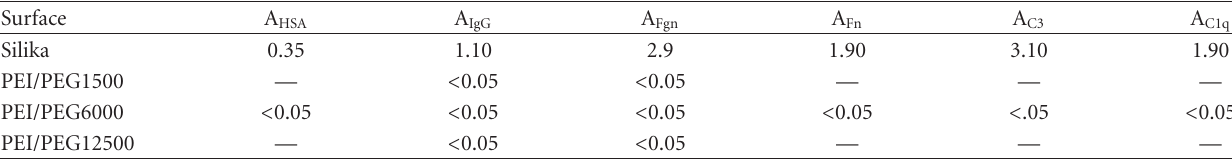
Table 2: Protein adsorption (mg/m 2 ) as measured by